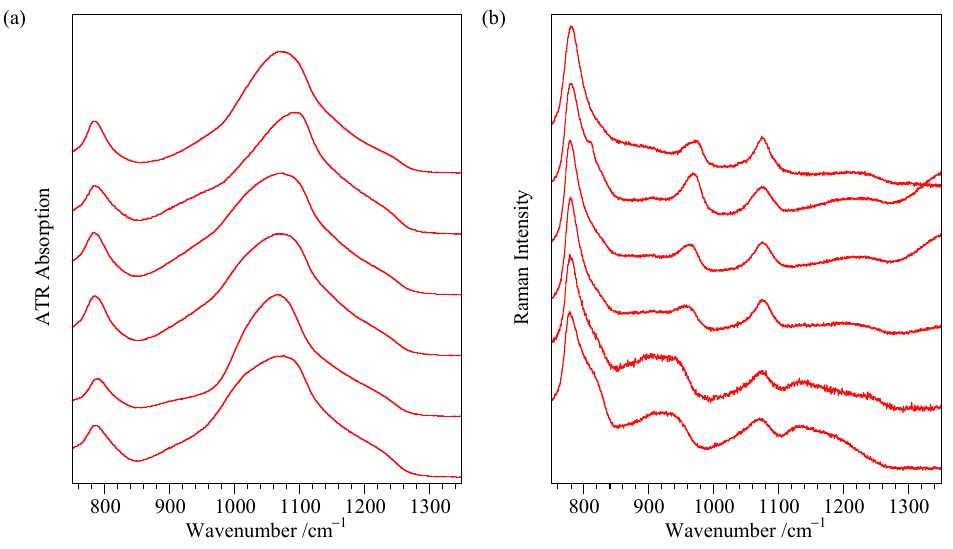
Figure 20. Comparison of ( a ) powder ATR IR and ( b ) Raman spectra for a range of opal-CT samples having different XRD patterns. The sample with the least structured XRD pattern is at the bottom and each sample in ascending order have incrementally more complex XRD patterns. Samples in ascending order are: G32752 (from Afar, Ethiopia), NMNH Eth S1 (from Mezezo, Ethiopia), G9964 (from Murwillumbah, Australia), G1441 (from Honduras), M53407 (from Kazaqstan), and G NEW19 (from Tanzania).